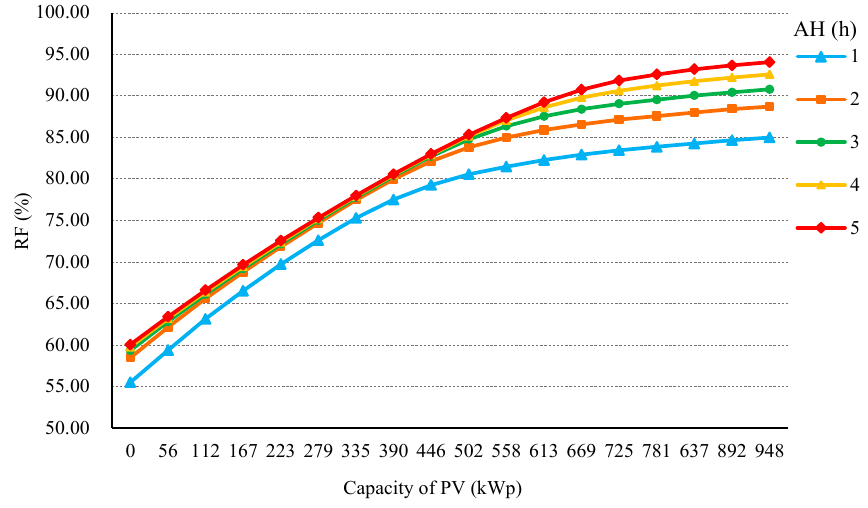
Figure 6. RF for different sizes of PV panels and autonomy-hour.